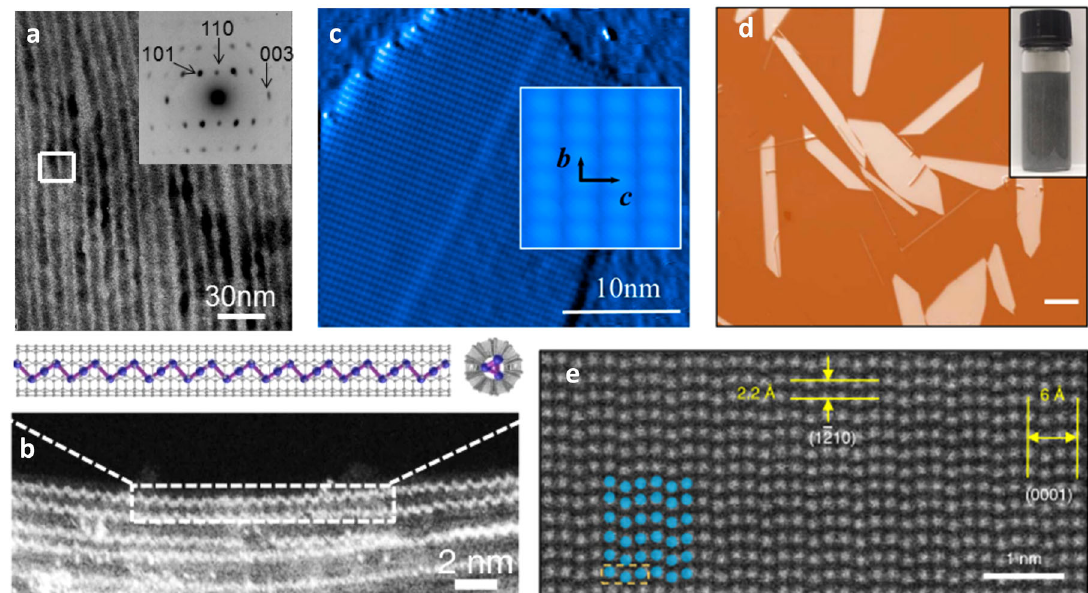
Fig. 2 Synthesis of Te 1D and 2D nanostructures. a Hydrothermally grown 1D Te nanowires with 4 nm diameter assembled by Langmuir- Blodgett technique. Reproduced from ref. 41 . b Single-chain 1D nanowires grown in boron nitride nanotube encapsulation. Reproduced from ref. 48 . c An STM image of a MBE-grown monolayer Te fi lm on graphene. Reproduced from ref. 33 . d Solution-based growth of 2D tellurium fi lms. The scale bar is 20 µm. Inset: Optical image of the Te solution dispersion. e An STEM image of a 2D Te fi lm. False-colored (in blue) balls highlight the helical structure. ( d , e ) reproduced from ref. 32